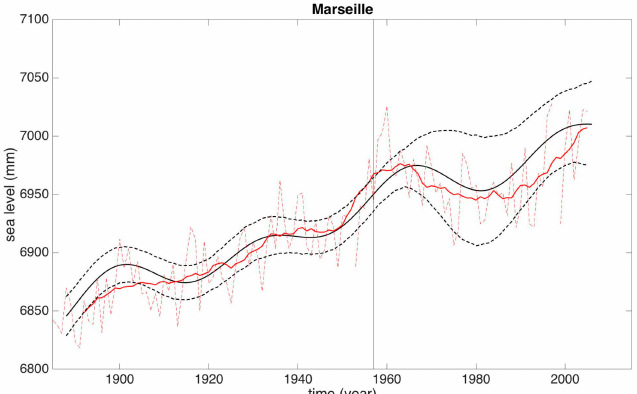
Figure 6. Sea levels in the period 1888–2007 at Marseille as estimated by deriving the model from the first 70 years (1888–1957) of tidal data. Fit parameters are: r = 1.57 ± 0.04; c = 3882 ± 75; A = 13.8 ± 1.0, 9.8 ± 1.01; Φ = 1.22 ± 0.06, 1.89 ± 0.09, R 2 = 0.91. The model (black line) with 90% confidence interval (enclosed by black dashed lines), sea-level data at 1 year of resolution (red dashed line) and smoothed by a 15-year sliding window (red line), are shown. The vertical bar marks the boundary between sea level data used for the model (left) and estimated sea levels